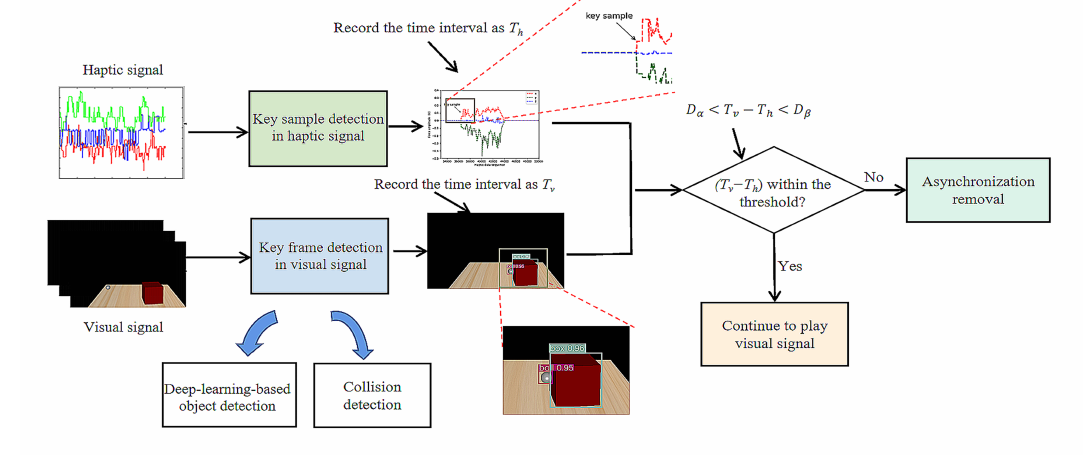
Figure 3. The flowchart of our proposed